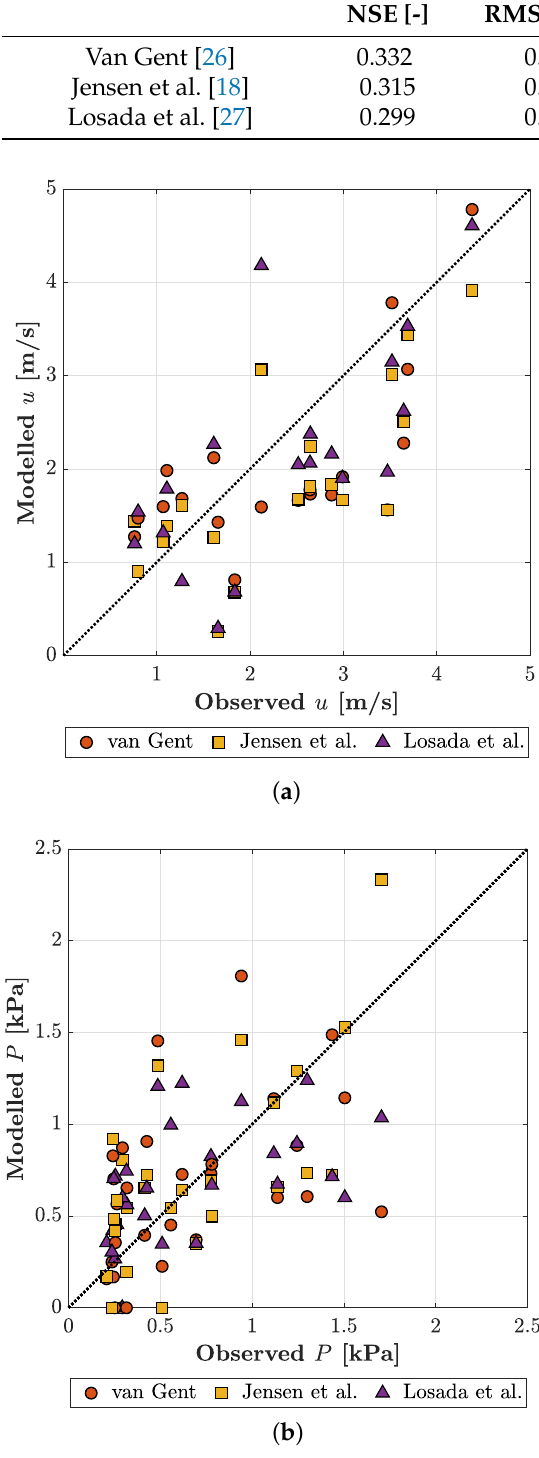
Figure 9. ( a ) Modelled against observed peak flow velocity u [m/s] at PW1 and PW2 per overtopping wave during t = 0–170s in Test B. ( b ) Modelled against observed peak pressure P [kPa] at PS2–PS5 per overtopping wave during t = 0–170s in Test